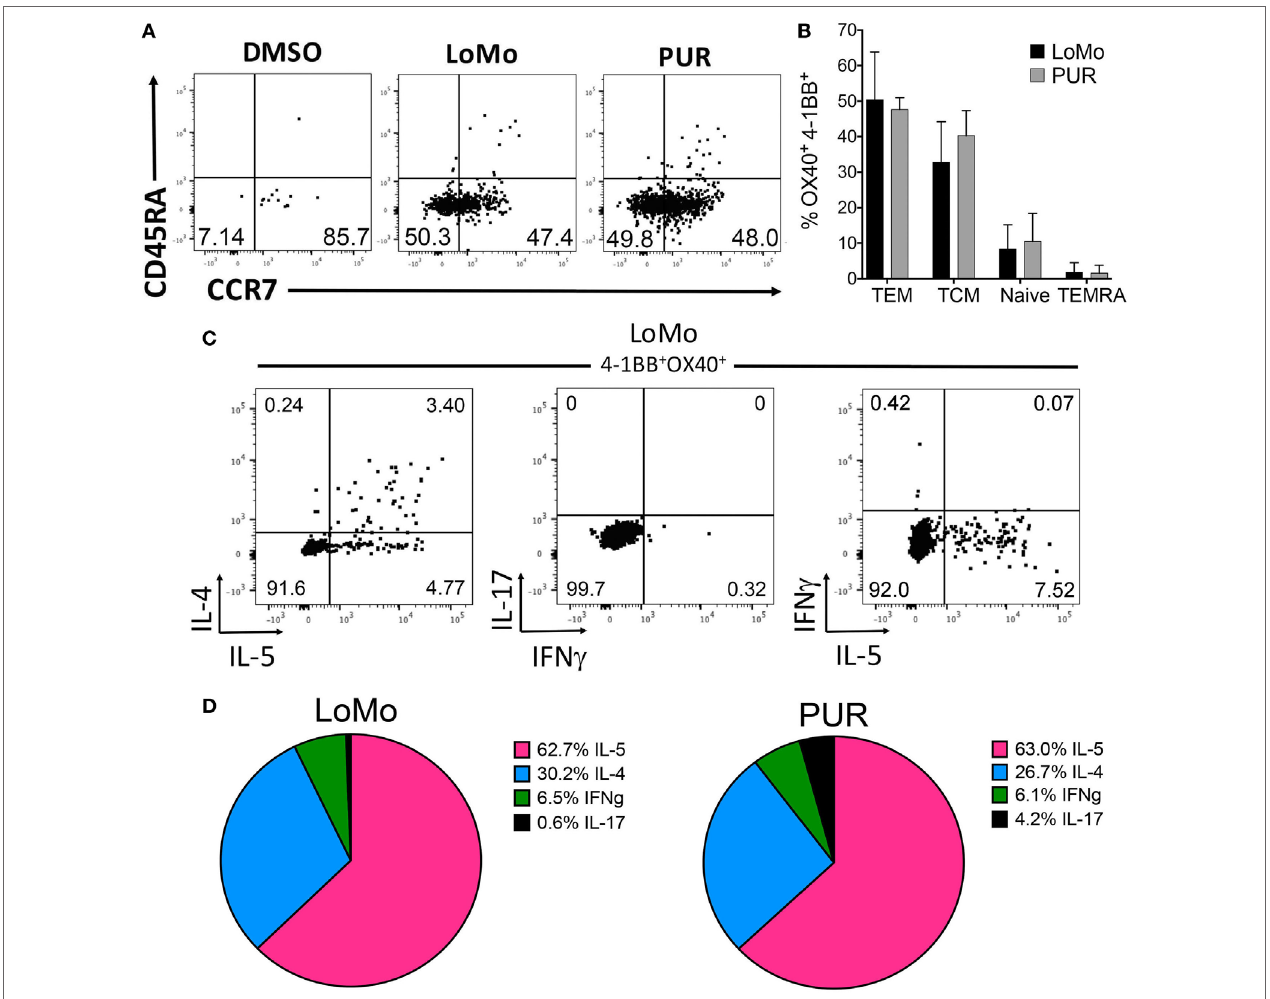
FigUre 6 | Phenotype and polarization of human LoMo-specific CD4 + T cells ex vivo . (a) Representative flow cytometry plots of 4-1BB + OX40 + CD4 + T cells gated on CD45RA and CCR7 expression after 24 h of stimulation. (B) Graph shows frequency of central memory (CD45RA − CCR7 + ), effector memory (CD45RA − CCR7 − ), naïve (CD45RA + CCR7 + ), and TEMRA (CD45RA + CCR7 − ) cells. Median ± interquartile range is represented for each population. (c) Representative flow cytometry plots of 4-1BB + OX40 + CD4 + T cells LoMo-specific cytokine production after AIM and ICS assays combined. (D) Patterns of cytokine production in LoMo or PUR antigen-specific T cells expressed as frequency of each individual cytokine ( n = 4)